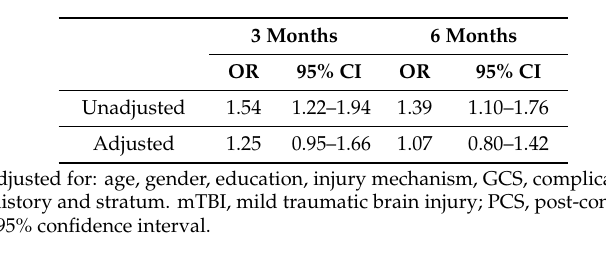
Table 3. Summary of covariate adjusted analysis for the association between complicated versus uncomplicated mTBI on the presence of PCS at 3 months and 6